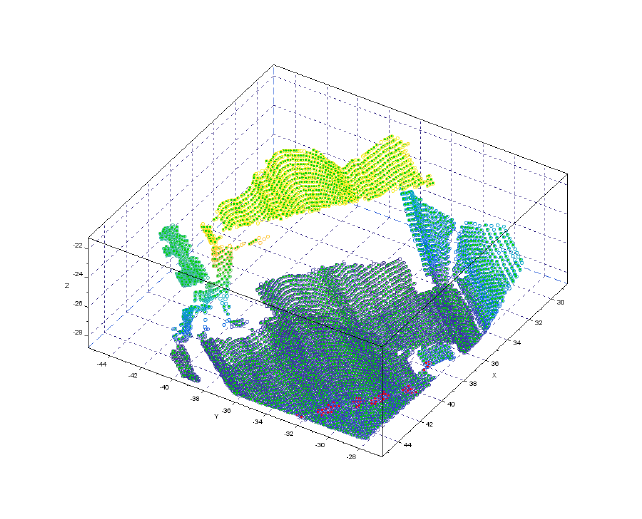
Figure 4. Result of the validation algorithm on the HEIG dataset. red. All segments are represented in various levels of